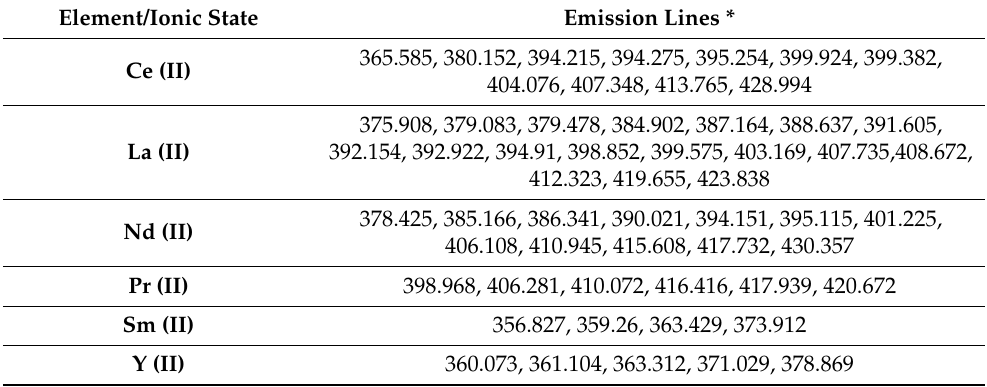
Table 3. The emission lines of different REEs in